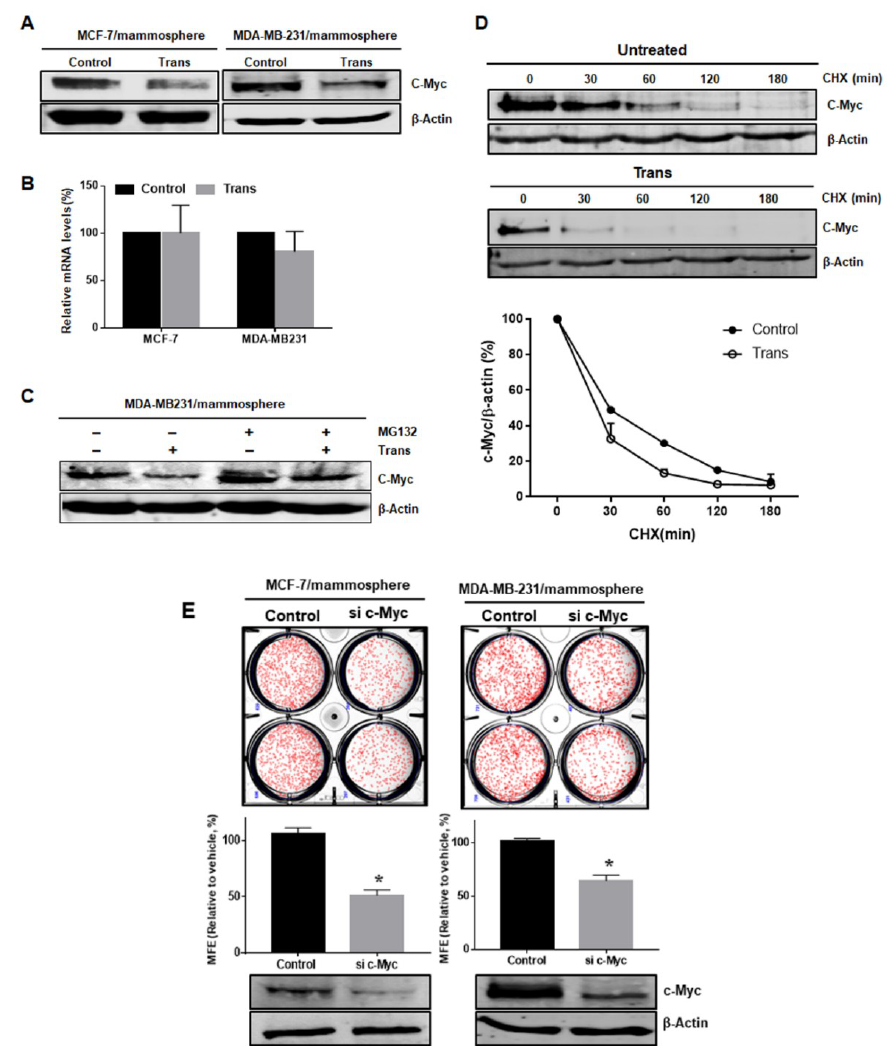
Figure 5. The trans -coumaroyltormentic acid (Trans) promotes the proteasome-mediated degradation of c-Myc in breast CSCs. ( A ) Trans reduced the protein level of c-Myc. Cells were treated with Trans (20 μM) for 24 h. Total cell lysates were subjected to Western blot analysis with specific antibodies. β-Actin was used as an internal control. ( B ) Transcriptional expression of c-Myc genes of CSCs was determined in Trans- and DMSO-treated mammospheres using c-Myc-specific primers and real-time PCR. β-Actin served as an internal control. ( C ) Mammospheres were incubated with MG-132 and Trans (20 μM) for 24 h and lysed for Western blot analysis. ( D ) The cycloheximide (CHX) chase assays showing the half-life of c-Myc protein. The mammospheres were treated with CHX at 100 μg/mL for the indicated times. The half-life of endogenous c-Myc protein was measured by Western blot and analyzed. Each point represents the mean ± SD of triplicate experiments. ( E ) Effect of c-Myc protein on mammosphere formation using siRNA knockdown of c-Myc. The mammospheres derived from siRNA-treated cells were cultured for seven days. Images were obtained by microscopy at 10× magnification and are representative mammospheres (scale bar = 100 μm). The data shown represent the mean ± SD of three independent experiments. * p < 0.05 vs. DMSO-treated control. All of the immunoblots are representative of more than three independent experiments.